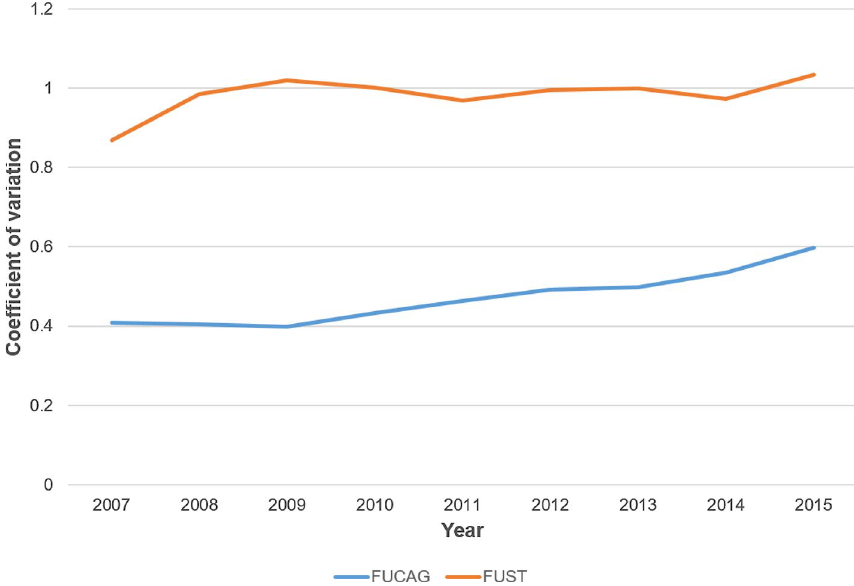
Figure 3. Hospital-level variations in follow-up strategy over years. FUCAG follow-up invasive coronary angiography, FUST follow-up stress testing.